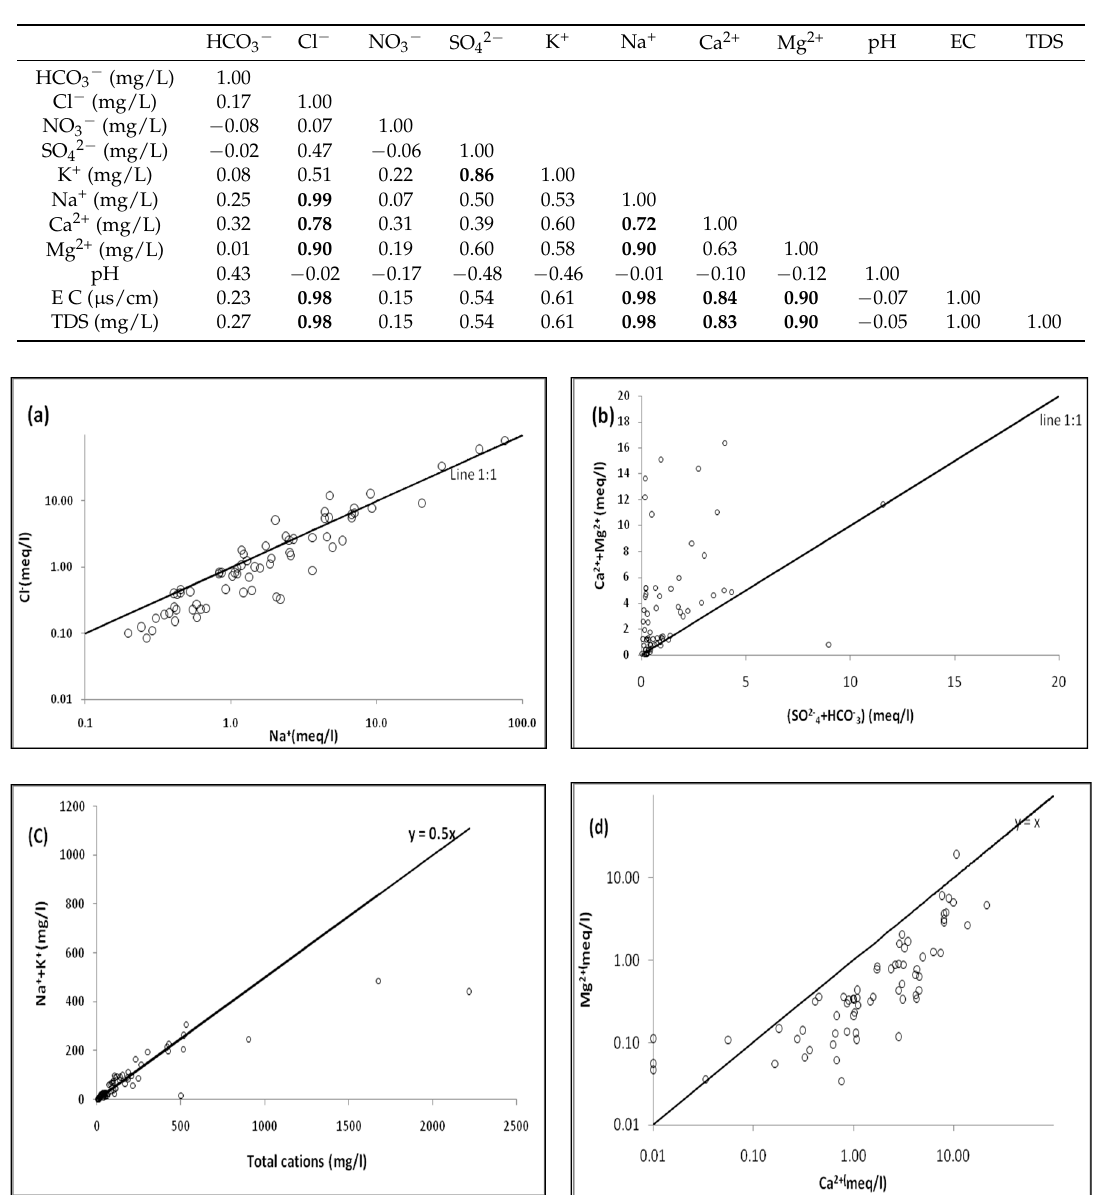
Figure 8. Bivariate plots of ( a ) Cl − vs. Na + , ( b ) Ca 2+ + Mg 2+ vs. SO 42 − + HCO 3 − , ( c ) Na + + K + vs. Total Cations, and ( d ) Mg 2+ vs. Ca 2+ .